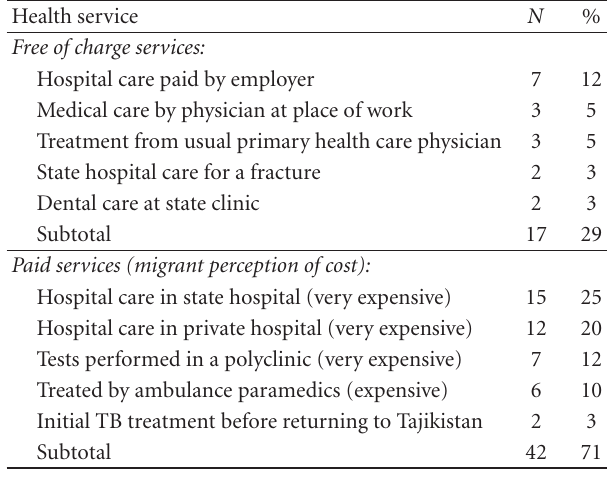
Table 1: Health services received abroad.